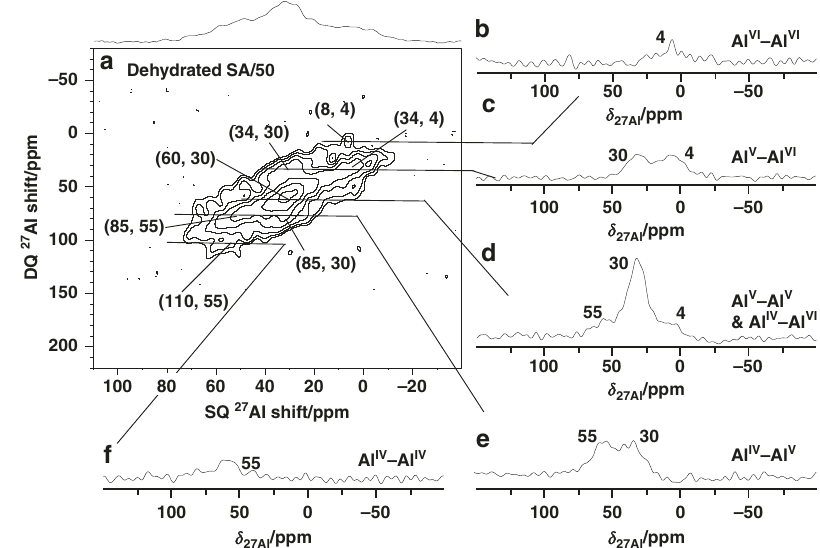
Fig. 3 27 Al DQ-SQ 2D NMR spectrum. a 27 Al 2D NMR spectrum recorded at 18.8 T with ν R = 20 kHz of SA/50 dehydrated at 723 K for 12 h under vacuum. b – f Rows extracted from the 2D spectrum corresponding to the various auto-correlations and cross peaks. All rows are plotted with the same intensity scale.